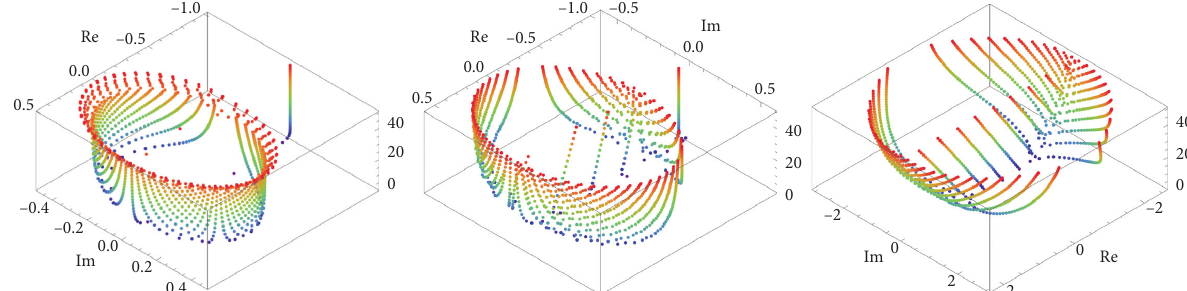
Figure 4: Zeros of S